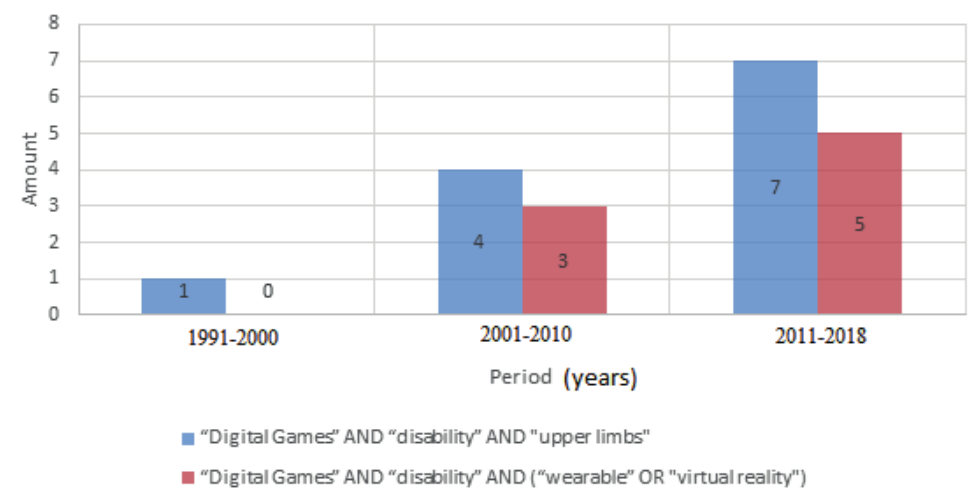
Figure 1 - Evolution of the publication of articles raised according to the keywords used in the